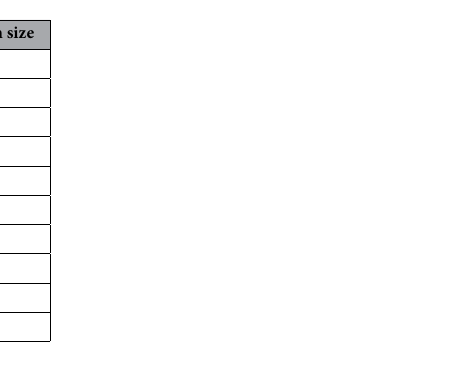
Table 2. Parameter details specific to each